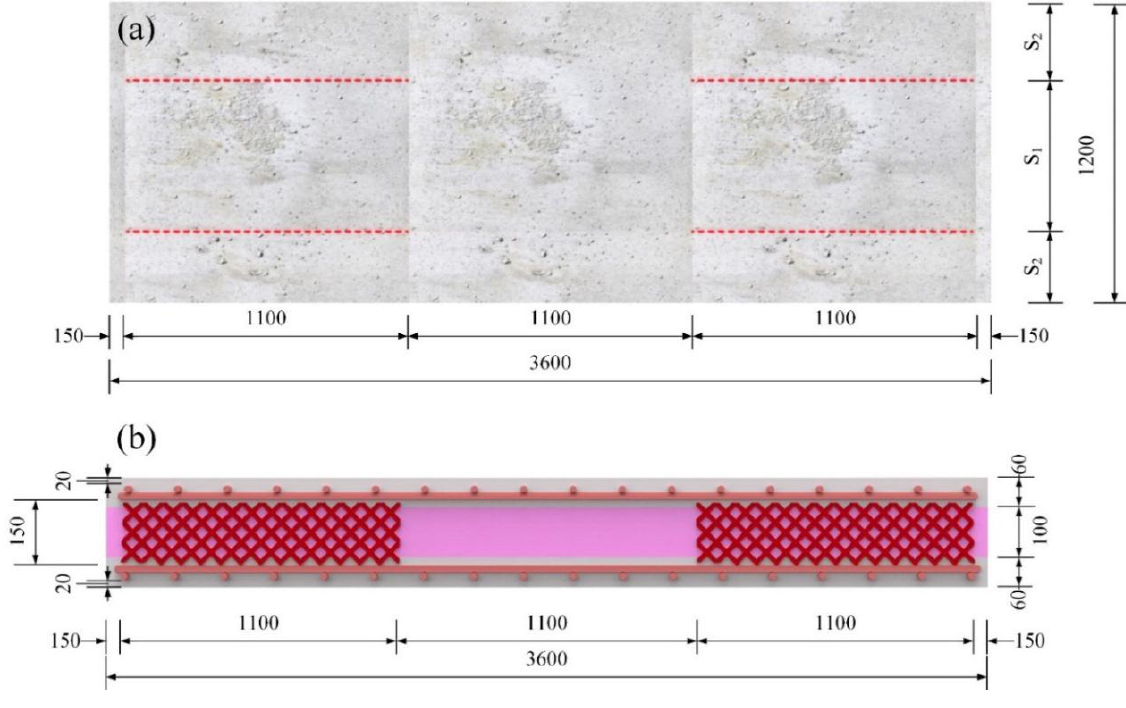
Figure 2. Typical dimension of specimens: ( a ) plan (2 grids on both shear spans); ( b ) section (2 grids on both shear spans).